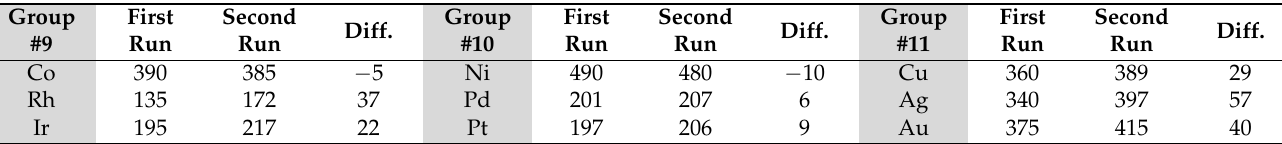
Table 1. CO oxidation onset temperatures (T M-Al2O3,onset ) in the first and second runs. Differences in CO oxidation onset temperatures (T M-Al2O3,2nd − T M-Al2O3,1st ) between the first and second runs. Group